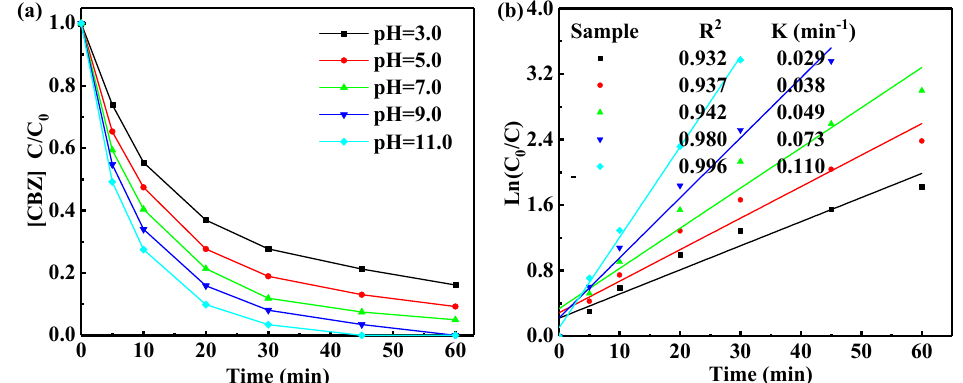
Figure 8. ( a ) Degradation of CBZ by UV-LED/TiO 2 under different pH conditions ( b ) The pseudo-first-order kinetic models of CBZ degradation by UV-LED/TiO 2 under different pH conditions. C(CBZ) 0 = 18.8 µM; operating temperature = 20 °C; and wavelength of UV-LED = 365 nm.